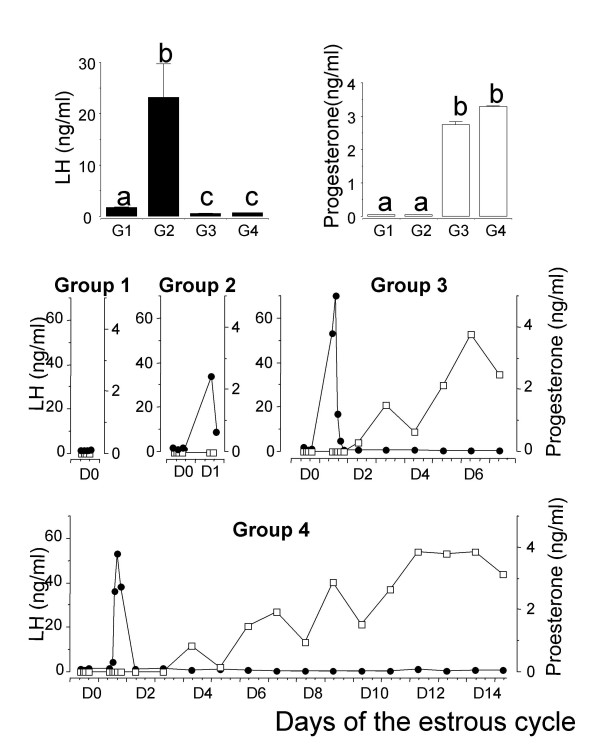
Top: Plasmatic hormone concentrations (Mean ± SEM) for LH (black bars) or progesterone (open bar) at the last sampling time before animals were sacrificed. Different letters indicate differences between groups (P < 0.05). Bottom: Individual plasmatic levels of LH (black circles) and progesterone (open squares) in ewes representative of each experimental group.